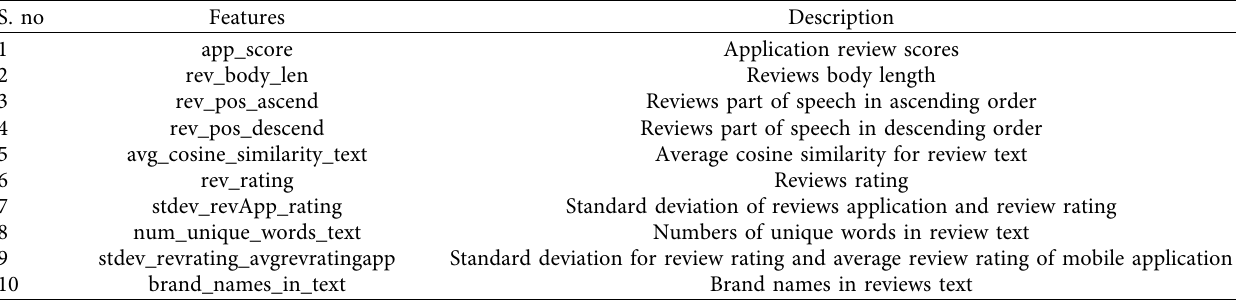
Table 3: Ten best features chosen by Chi-square for Yelp Dataset.